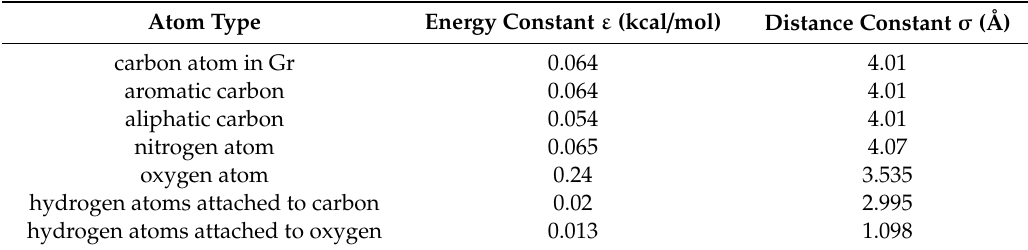
Table 1. LJ potential parameters for di ff erent